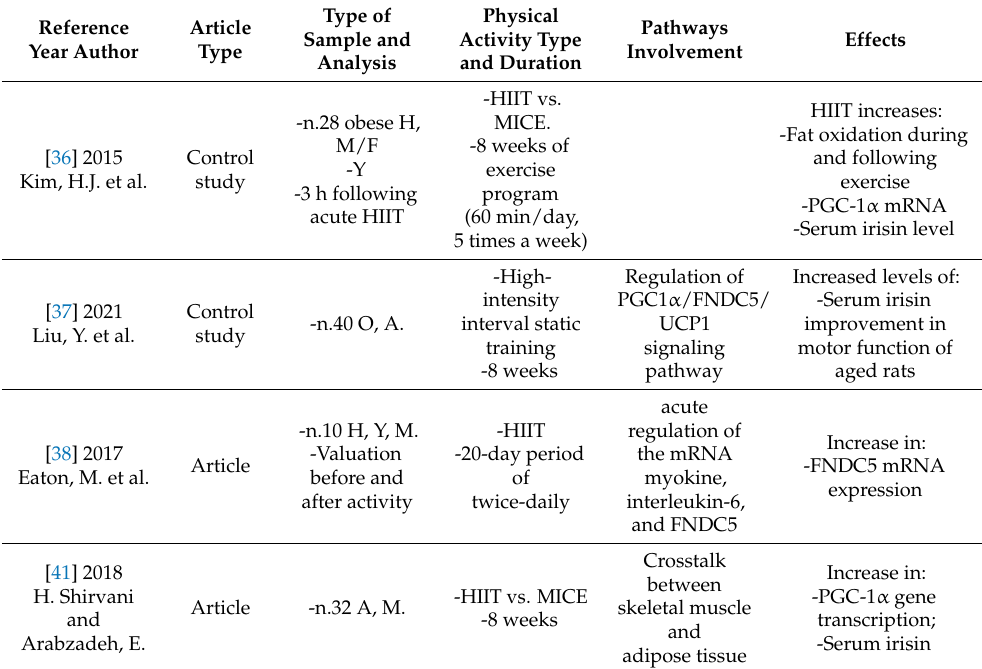
Legend Table 1: S: sex; H: human; A: animal test (mice or rats); M: male; F: female; O: old; Y: young; C: cells. HIIT: high-intensity interval training; MICE: moderate-intensity continuous exercise; OPG: osteoprogeterin, RANK: receptor activator of NF κ B; RANKL: receptor activator of NF κ B ligand; RUNX2: runt-related transcription factor 2; MSX1: Msh homeobox 1; SPP1: secreted phosphoprotein 1; BMP2: bone morphogenetic protein2; BMP6: bone morphogenetic protein6; PPAR γ : proliferator-activated receptor gamma; PGC-1 alfa: peroxisome proliferator-activated receptor gamma coactivator-1alfa; FNDC5: fibronectin type III domain-containing protein 5 gene; UCP1: uncoupling protein